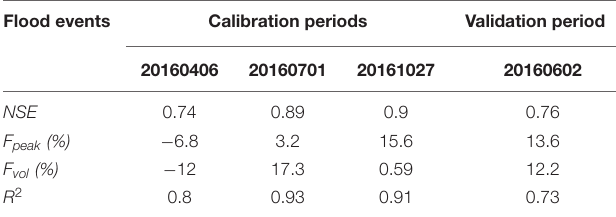
TABLE 3 | Simulation performances of hydrograph of selected flood events in high inflow year by the coupled water balance method and Xin’anjiang model. Flood events